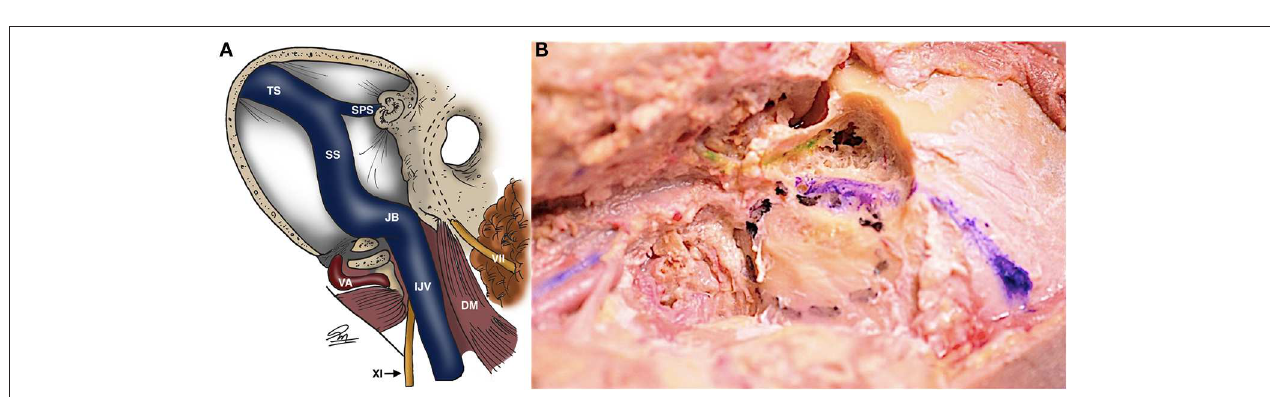
FIGURE 7 | Schematic (A) and cadaveric (B) views of the jugular foramen with its vascular relationships and the facial nerve in the fallopian canal [dashed lines in (A) , green in (B) ]. Transverse and sigmoid sinuses are blue in (B) [Modified from Ramina and Tatagiba (3)]. DM, digastric muscle; IJV, internal jugular vein; JB, jugular bulb; SPS, superior petrosal sinus; SS, sigmoid sinus; TS, transverse sinus; VA, vertebral artery. VII, facial nerve; XI, glossopharyngeal nerve.